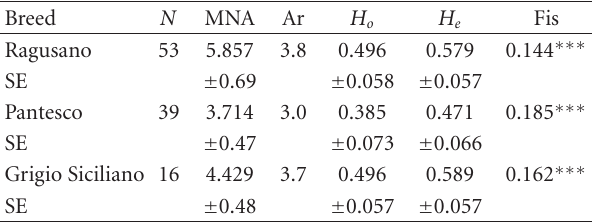
Table 1: Number of alleles, observed ( H o ) and expected heterozy- gosity ( H e ), and PIC values per locus inferred on the whole sample of three Sicilian donkey breeds.